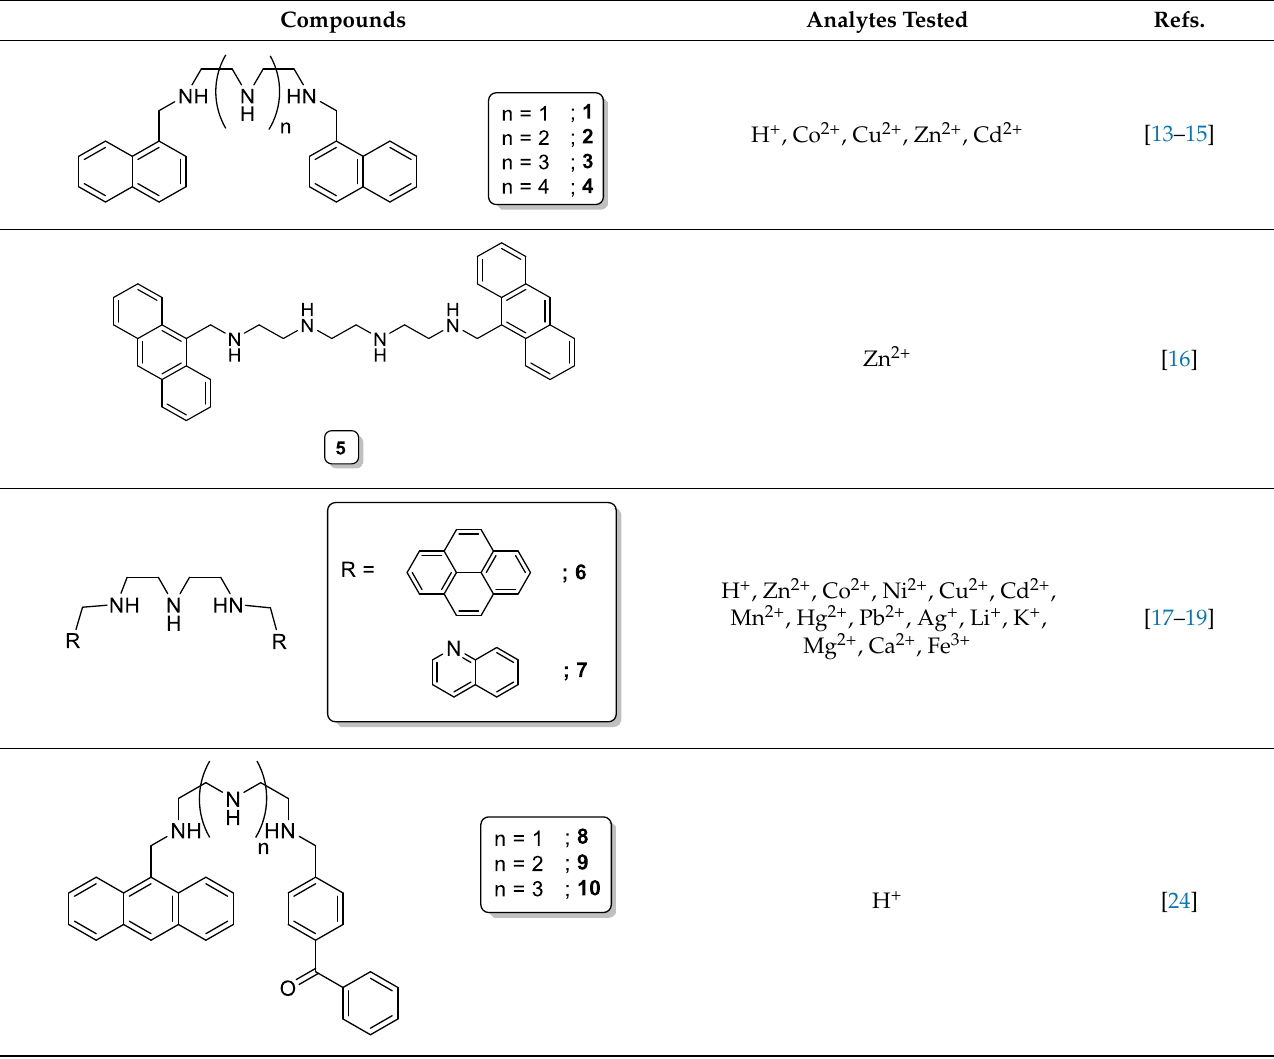
Table A1. Summary of the chemosensor structures, analytes, and corresponding references.